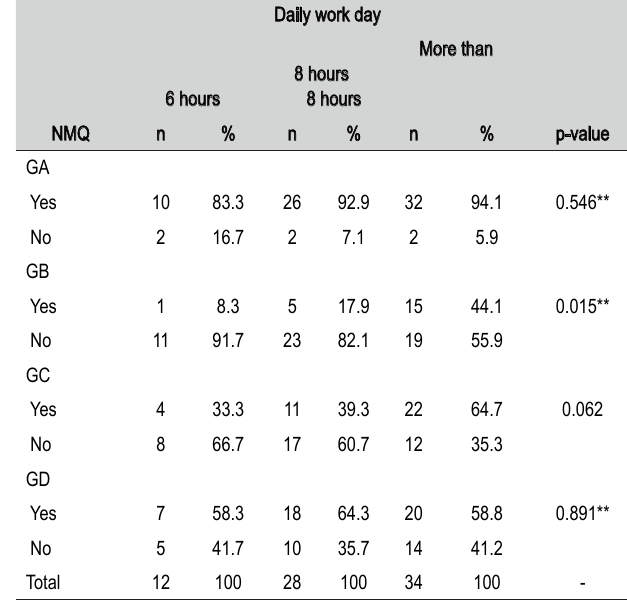
Table 3 - Association between general questions of the NMQ and daily work day among dentists. São Paulo, Brazil, in